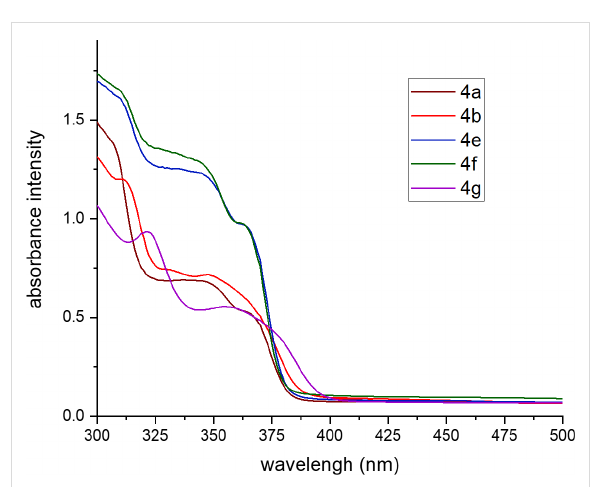
Figure 2: UV–vis absorption spectra of 4a , b and 4e–g in diluted dichloromethane solutions at room temperature ( c = 1 × 10 − 5 M).